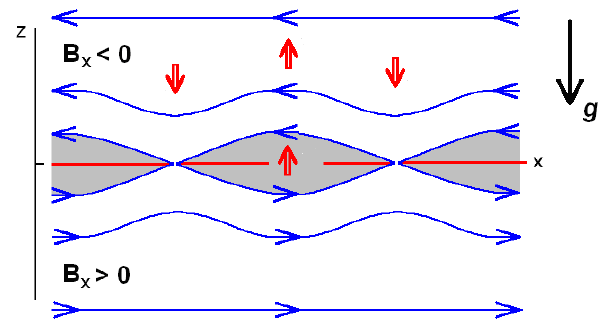
Fig. 7. Formation of plasma islands as a result of magnetic re- connection in combination with turbulent magnetic fields or inter- change perturbations oriented at some angle to the magnetic field. The appearing islands of heated plasma move upward against the gravitational acceleration, g . The blue lines show the magnetic field; the red arrows show upward motion of the plasma bubbles and downward flow of the surrounding